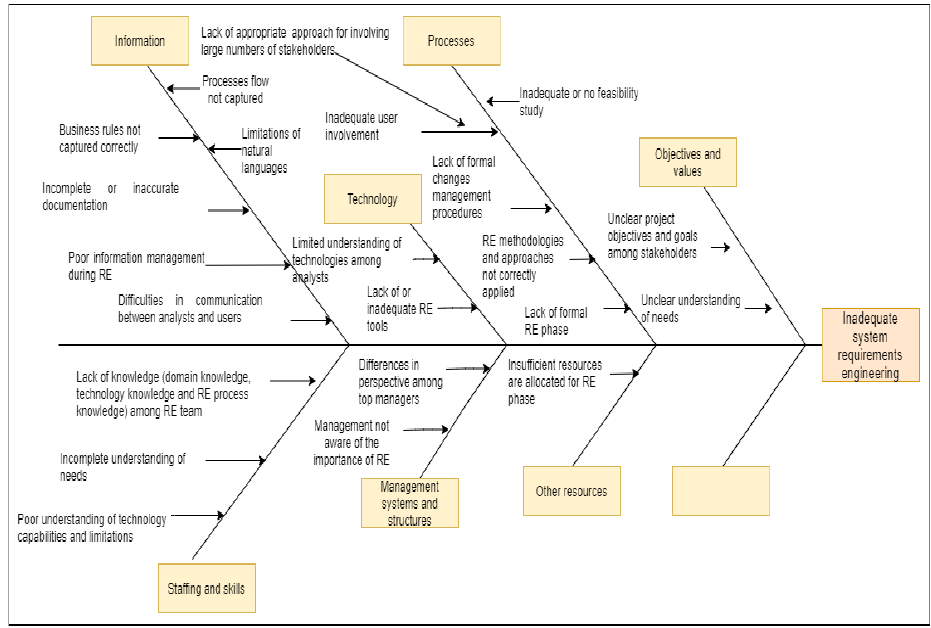
Figure 2: Inadequate system requirements